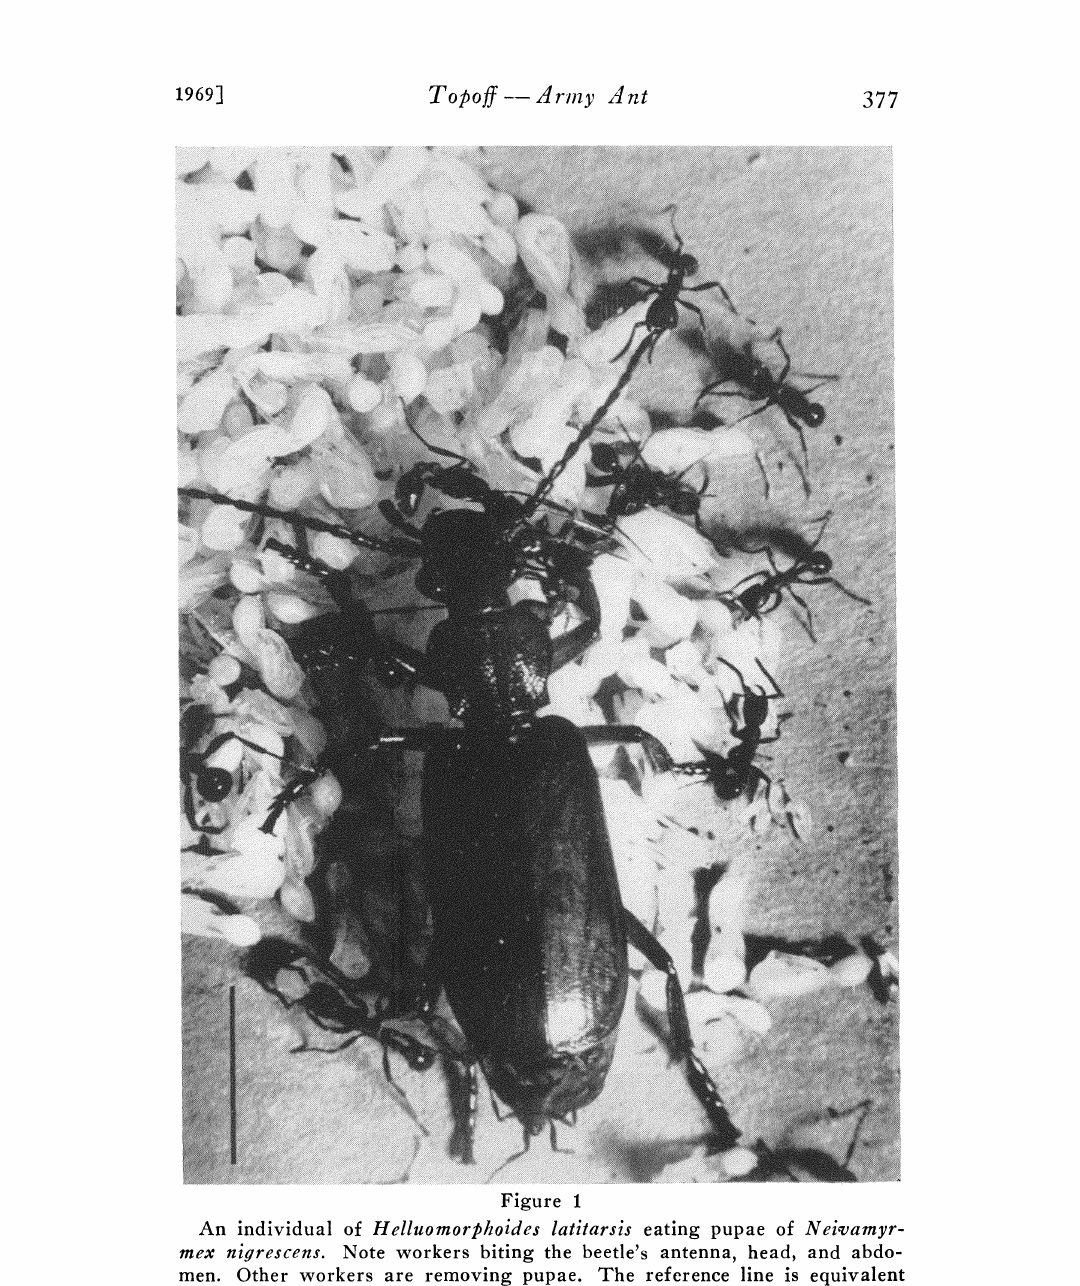
An individual of Helluomorhoides latitarsis eating pupae of Neivamyr- mex nigrescens. Note workers biting the beetle’s antenna, head, and abdo- men. Other workers are removing pupae. The reference line is equivalent to